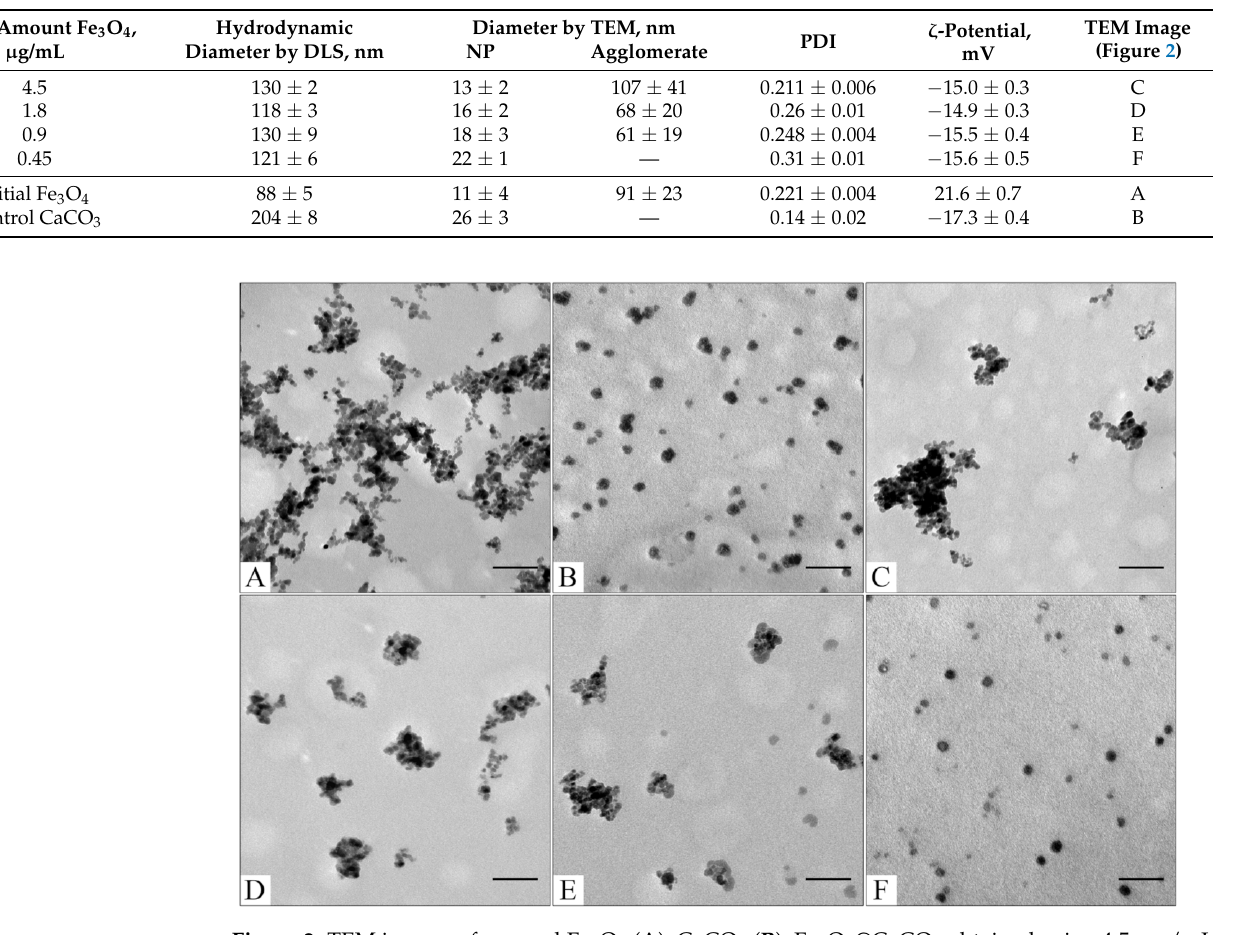
Figure 2. TEM images of sourced Fe 3 O 4 ( A ); CaCO 3 ( B ); Fe 3 O 4 @CaCO 3 obtained using 4.5 mg/mL ( C ); 1.8 mg/mL ( D ); 0.9 mg/mL ( E ); 0.45 mg/mL of Fe 3 O 4 ( F ). The bar indicates 100